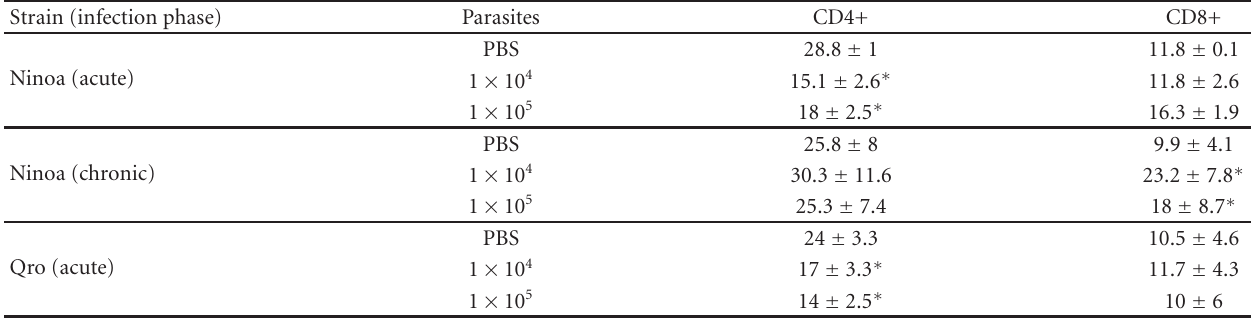
Table 2: Percentage of CD4+ and CD8+ lymphocytes in mice infected with T. cruzi I